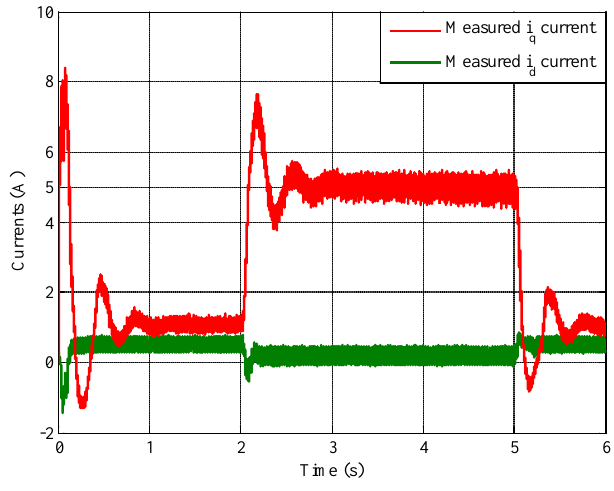
and under PI i d i q